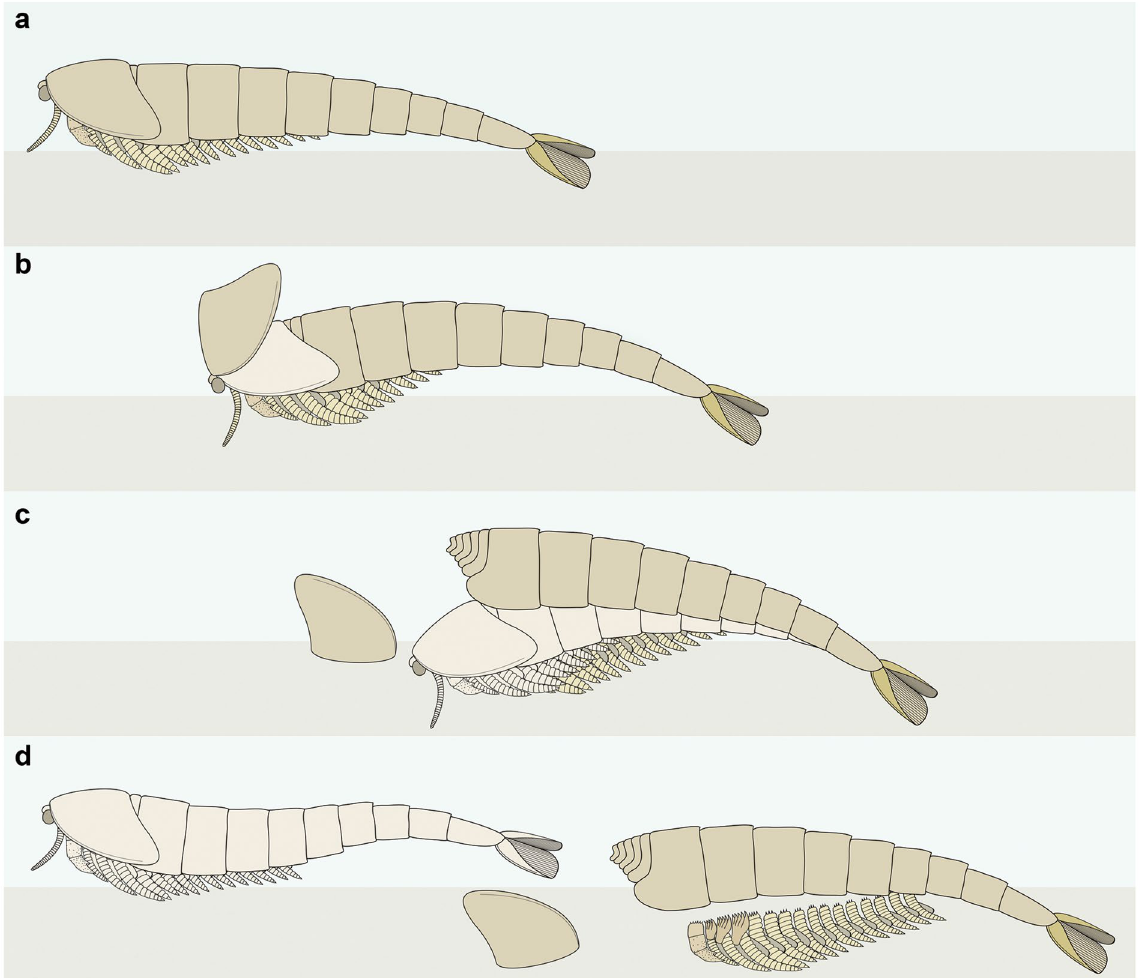
Figure 4. Reconstruction of ecdysis in Alacaris mirabilis based on the Open Moult Position strategy. ( a ) Inter- moult stage; note that the anterior reduced tergites are covered by the head shield in life position. ( b ) Ecdysis begins with the posterior detachment of the head shield, partially revealing the underlying anterior reduced tergites. ( c ) As the emerging individual pushes against the exuvia, the old head shield is inverted and separated from the body, and the appendages become separated from the trunk; the preservation of YKLP 12270 suggests it was buried during this stage. ( d ) The soft individual emerges completely through the resulting gape, leaving the partially articulated exuvia